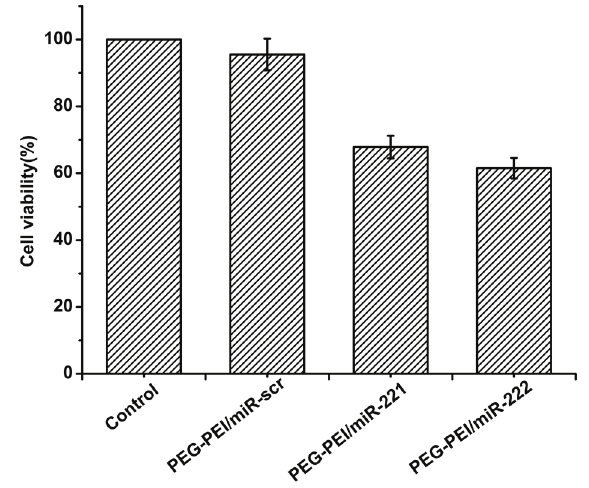
Figure 7: Viabilities of PC-3 cells treated with different samples. Three polyplexes were all synthesized at